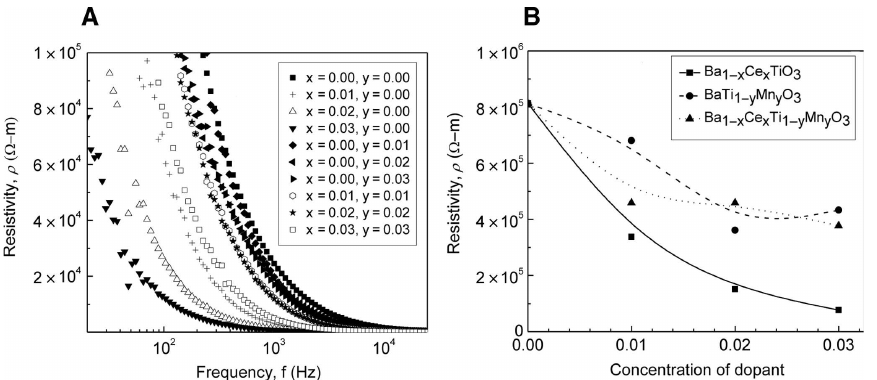
Figure 6: Plot of the (A) resistivity versus frequency and (B) resistivity versus concentration of additive curves of all the samples at room